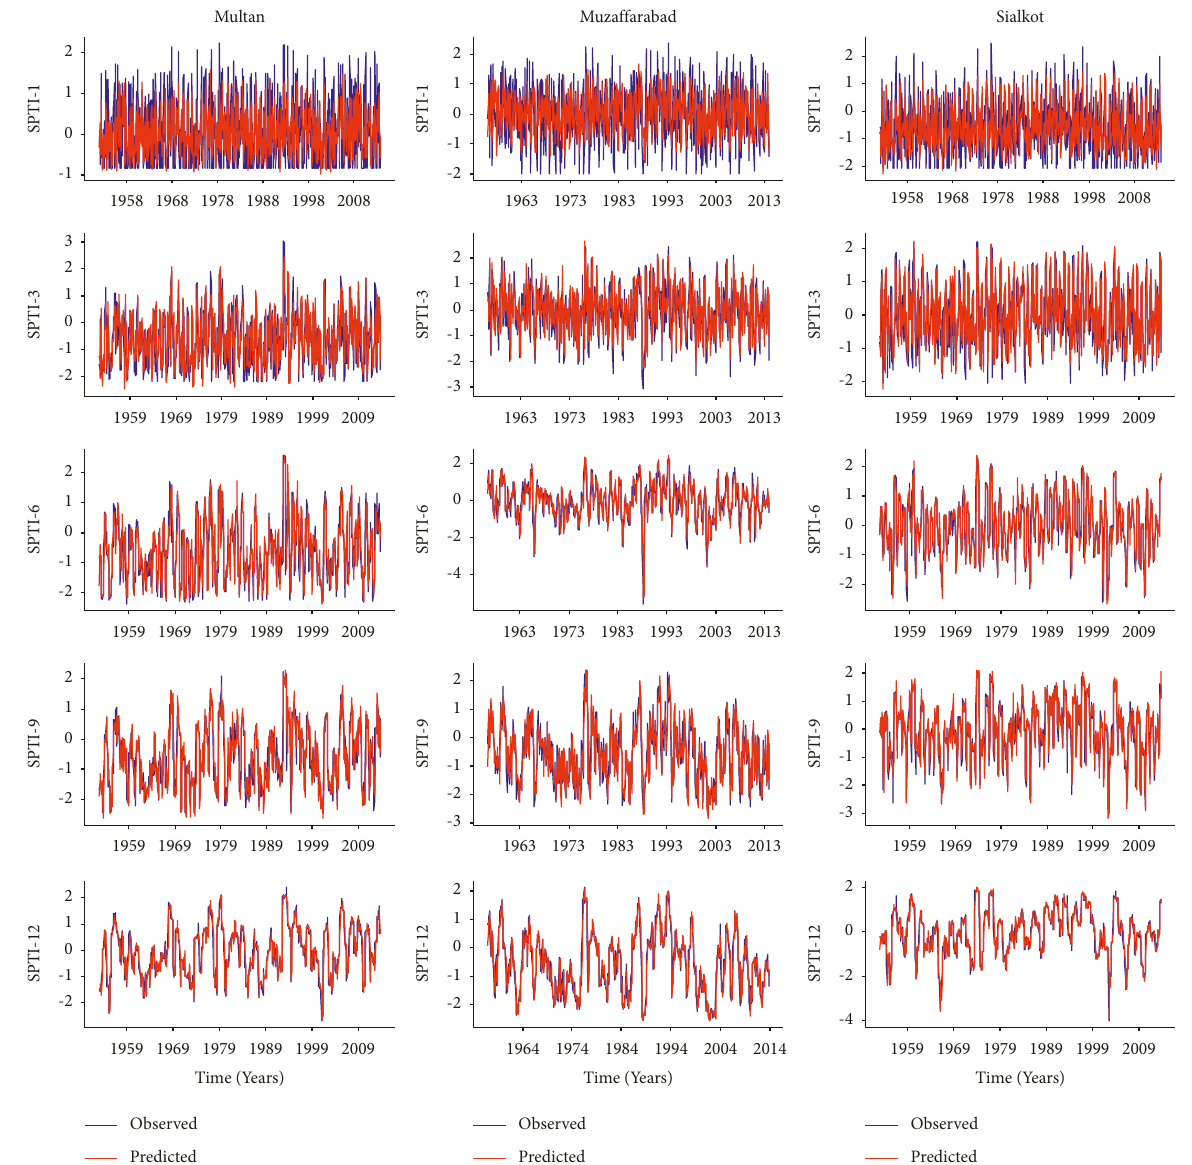
Figure 7: Co-movement of the observed and predicted values of SPTI using ELM at Muzaffarabad, Multan, and Sialkot stations for the training